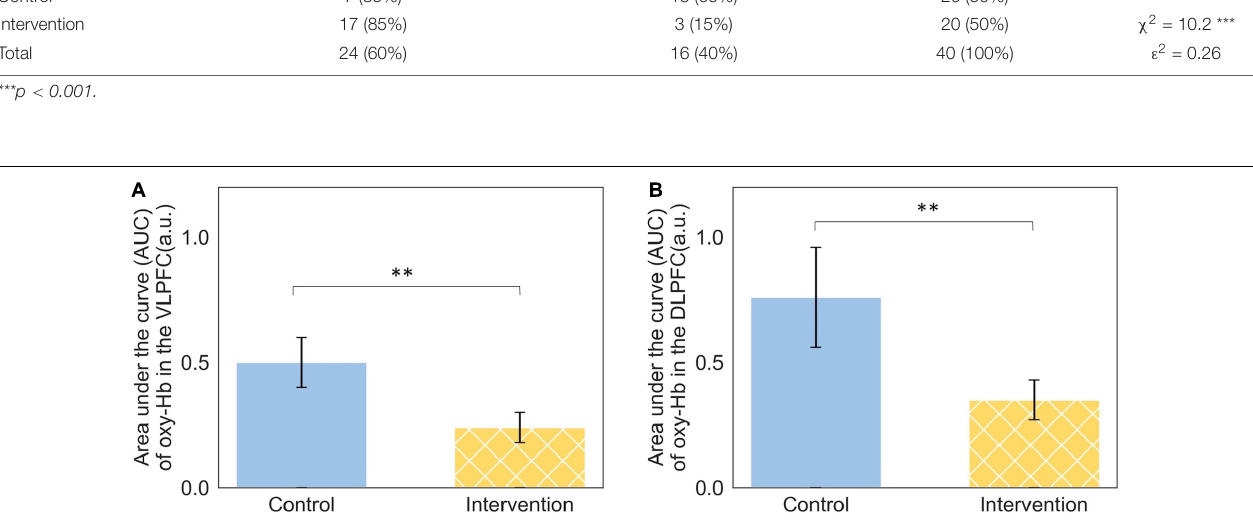
TABLE 1 | Distribution of engineering students recommending green or conventional infrastructure. Number of choices (percentage)